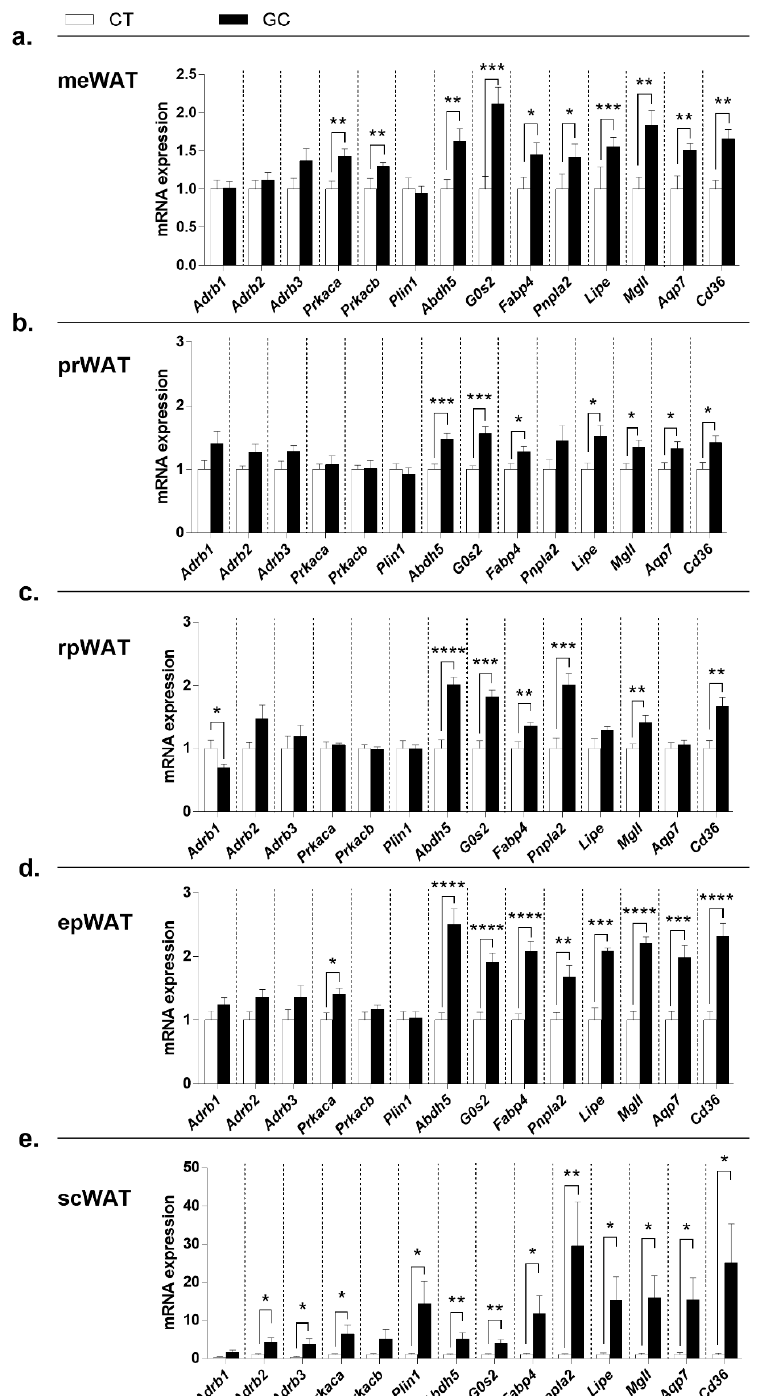
Figure 5 . Gene expression of the lipolytic pathway in white adipose tissue. ( a ) mesenteric—meWAT; ( b ) perirenal—prWAT; ( c ) retroperitoneal—rpWAT; ( d ) epididymal—epWAT; and ( e ) subcutaneous inguinal—scWAT. Genes of beta-adrenergic receptors— Adrb1, Adrb2 , and Adbr3; catalytic subunits of PKA— Prkaca and Prkacb ; perilipin in white mature adipocytes— Plin1 ; lipase cofactors— Abdh5, G0s2 , and Fabp4 ; lipases— Pnpla2, Lipe , and Mgll ; lipolytic products channel and transporter— Aqp7 and Cd36 —of control (CT; n = 7–12), and glucocorticoid-treated (GC; n = 11–12) rats. Data are mean ± SEM. * p < 0.05; ** p < 0.01, *** p < 0.001, and **** p < 0.0001 vs. CT (unpaired Student t -test; Mann–Whitney test in ( a ) ( Adrb2, Adrb3, Fabp4, Abdh5, Mgll , and Aqp7 ), ( b ) ( Adrb3 and Fabp4 ), ( c ) ( Adrb2 and Adrb3 ), ( d ) ( Adrb2, Adrb3 , and Prkacb ), and e (all, except G0s2